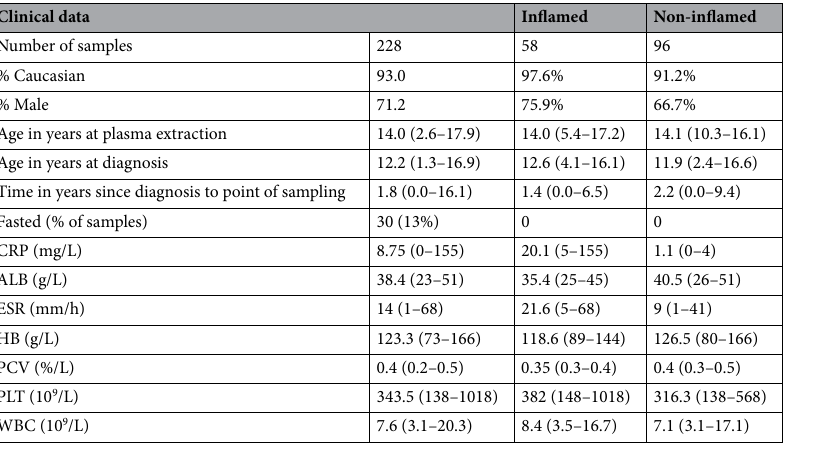
Table 1. Demographic and blood result data. Mean value is shown with (minimum–maximum) Ancestry was inferred from genomic data.